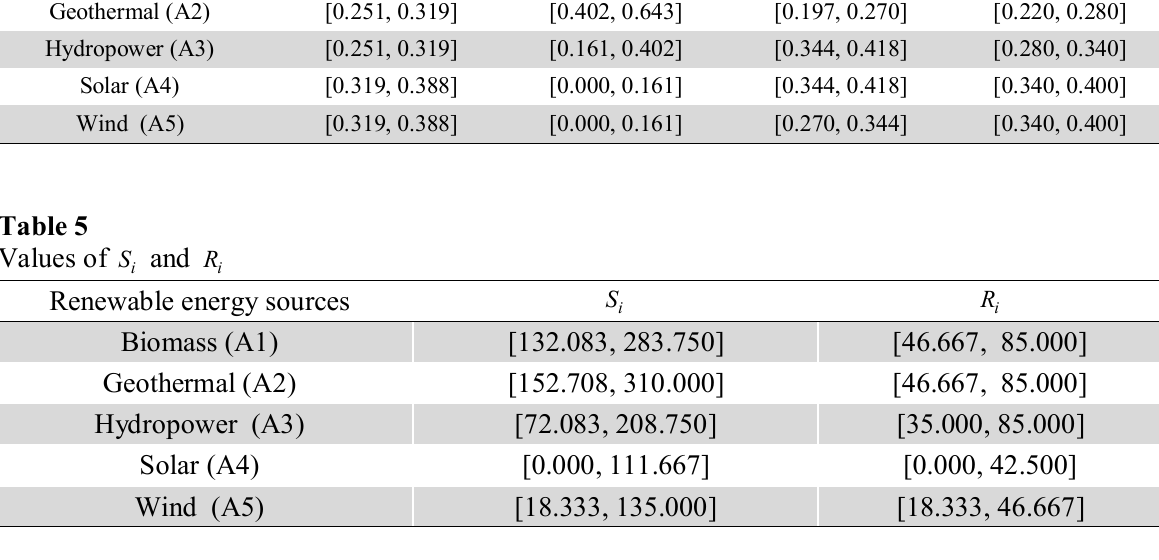
Normalized decision matrix with interval numbers